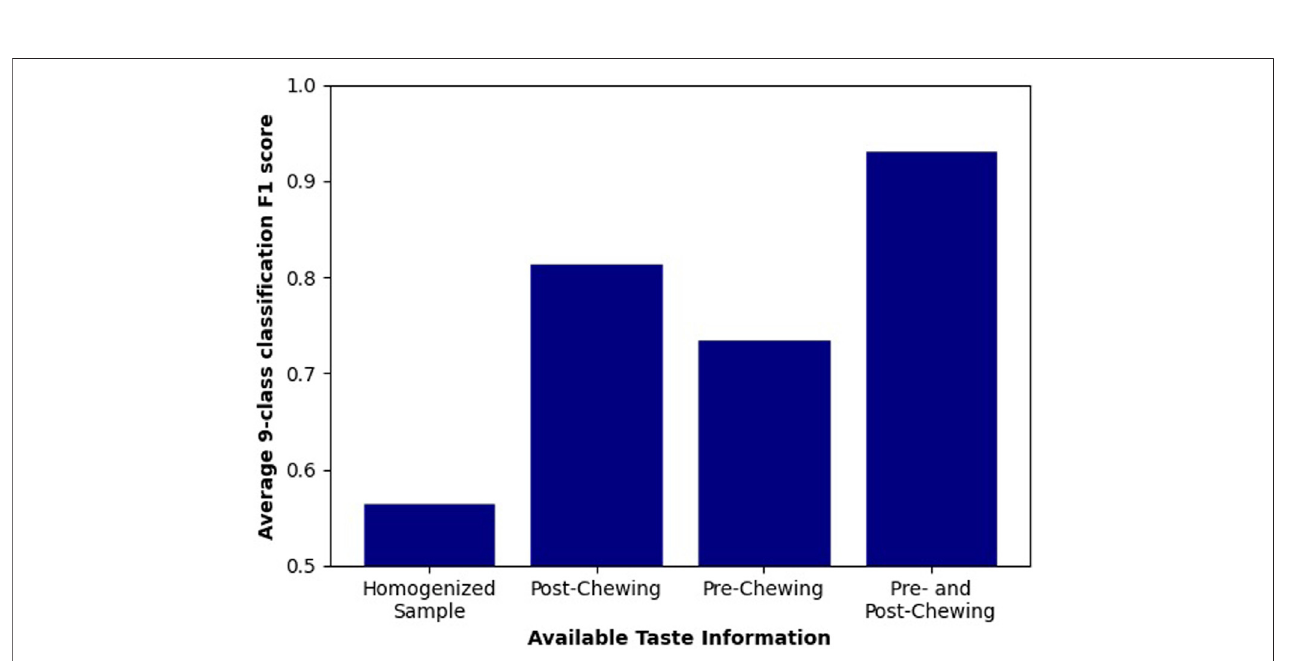
FIGURE 11 | F1 score averaged from dish speci fi c classi fi cations. It shows a steady growth of F1 score while additional information is introduced.